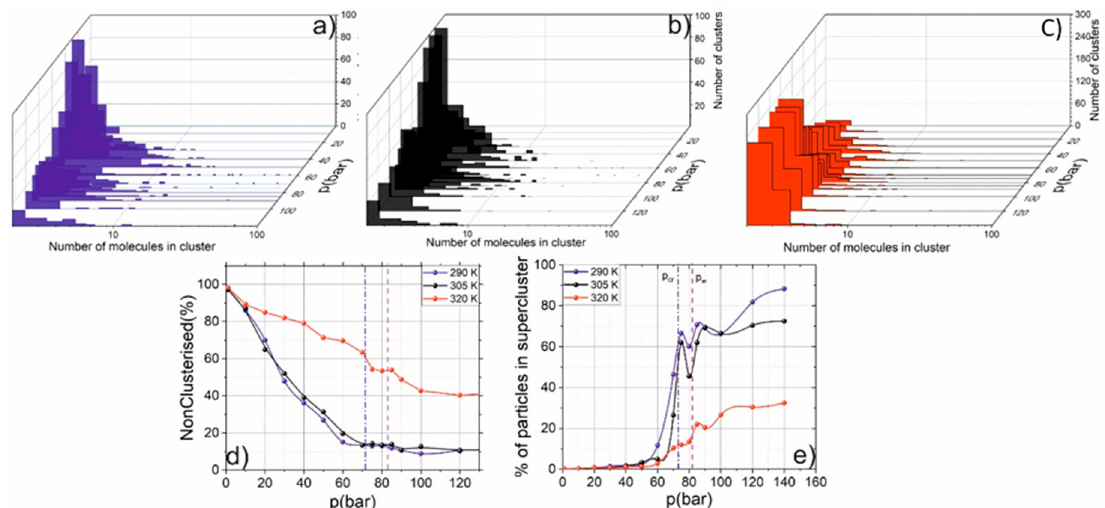
Figure 2. ( a – c ) Histograms of the cluster size distribution (in the log scale) T = 290 K ( a ), 305 K ( b ) and 320 K ( c ). Dependence of the non-clustered molecules ( d ) and number of particles in the supercluster ( e ) on pressure at constant temperature.